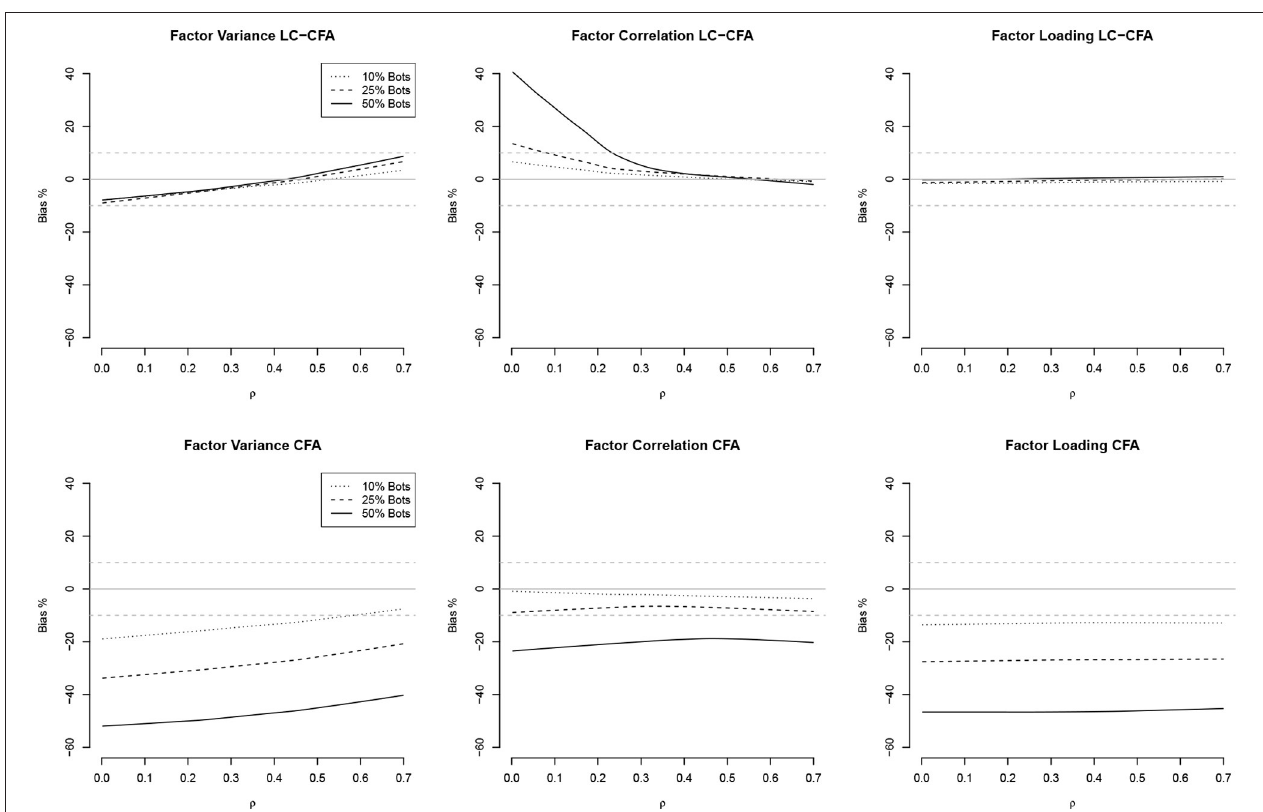
FIGURE 3 | Relationships (loess approximations) between factor correlations ( ρ ) and the bias of factor variances, factor correlations, and factor loadings from the LC-CFA (top) and CFA (bottom) . The bias was averaged across conditions of sample size and model complexity.